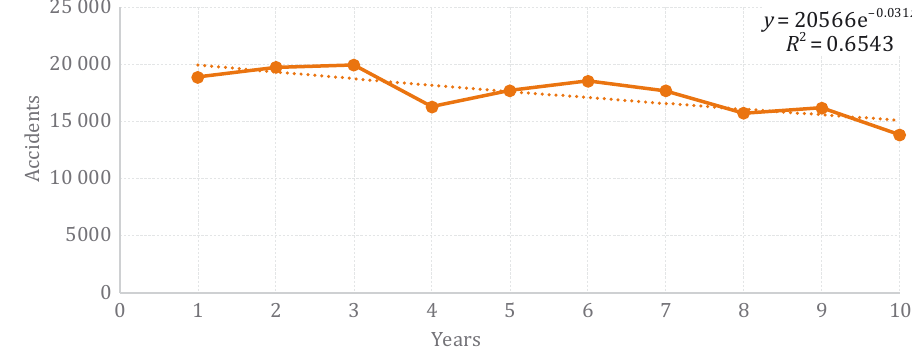
Figure 7. Number of accidents for the period of 2011–2020 associated with an exponential trend